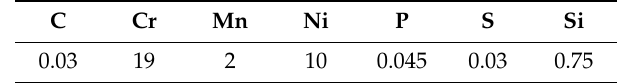
Table 2. Chemical composition (%) of the work piece material (Stainless Steel 304).